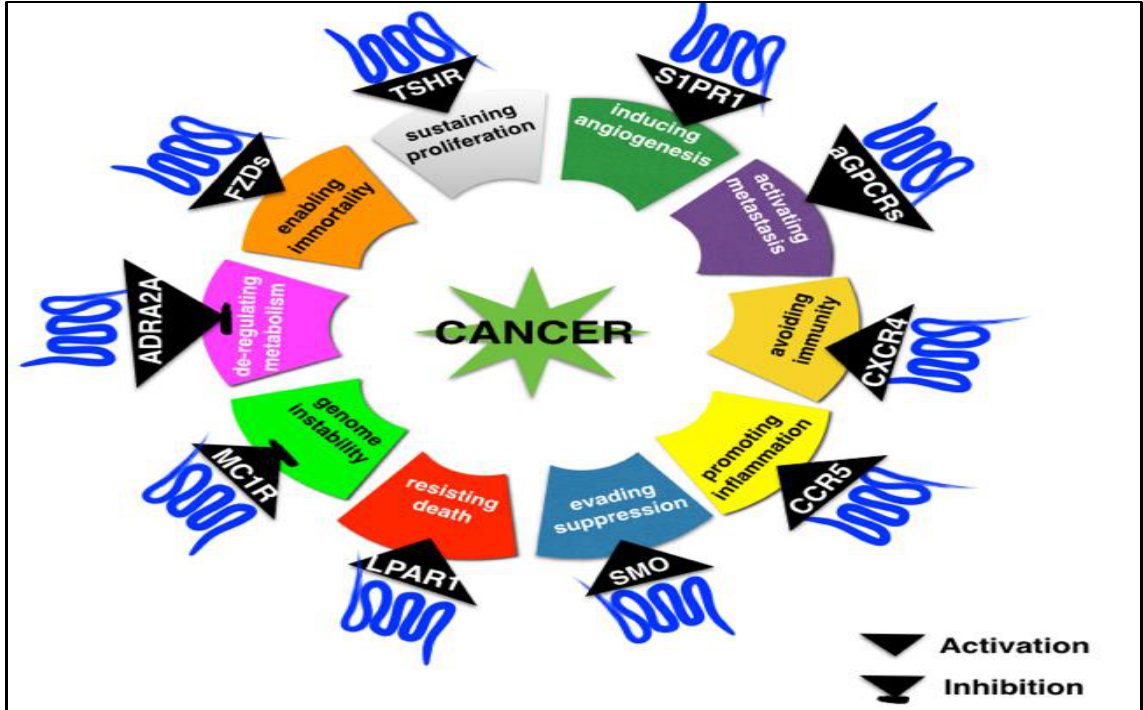
Figure 5. Depiction of the influence of selected GPCRs on the various ten hallmarks of cancer.(TSHR- thyroid-stimulating hormone receptor, S1PR1-Sphingosine-1-phosphate receptor 1, aGPCRs-adhesion G protein-coupled receptors, CXCR4-chemokine receptor type 4, CCR5-chemokine receptor type 5, SMO- Smoothened, LPAR1-Lysophosphatidic acid receptor 1, MC1R-Melanocortin 1 receptor, ADRA2A-alpha- 2A adrenergic receptor, and FZDs-Frizzled